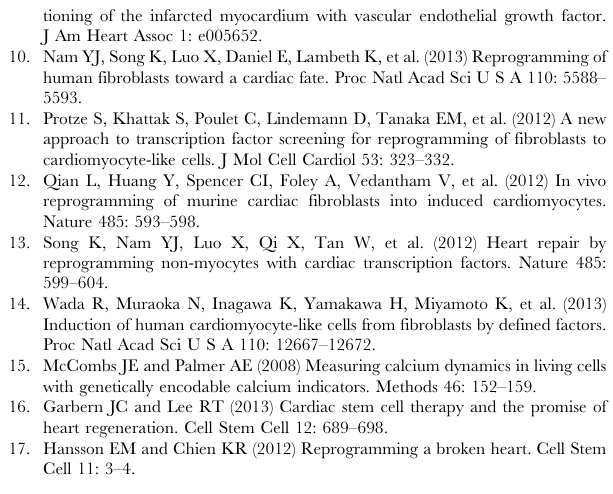
Figure S6 Heatmap for genes commonly associated with fibroblasts for MEFs and CFs at Day 3 post- induction in HNGMT + SB versus HNGMT + DMSO, with fold change and false discovery rate (FDR) values on the table to the right (top). Heatmap of genes up-regulated and down-regulated in MEFs for HNGMT + SB versus HNGMT + DMSO with functional annotations for the genes up- regulated or down-regulated exclusively in HNGMT + SB versus HNGMT + DMSO on the tables to the right (bottom). Movie S2 Groups of iCMs converted from MEFs beating synchronously at Day 18 post-induction. mouse CFs were observed to be beating through at least Table S1 Genes up-regulated in HNGMT + SB versus HNGMT + DMSO for both MEFs and CFs at Day 3 post- induction. Table S2 Genes that are down-regulated in HNGMT + SB versus HNGMT + DMSO for both MEFs and CFs at Day 3